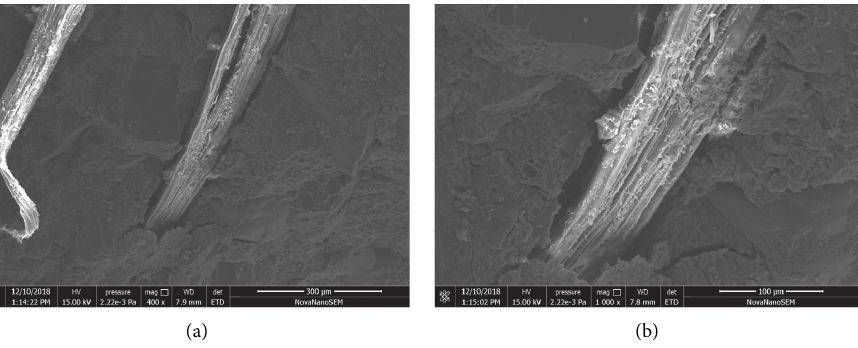
Figure 11: Bonding between PL and